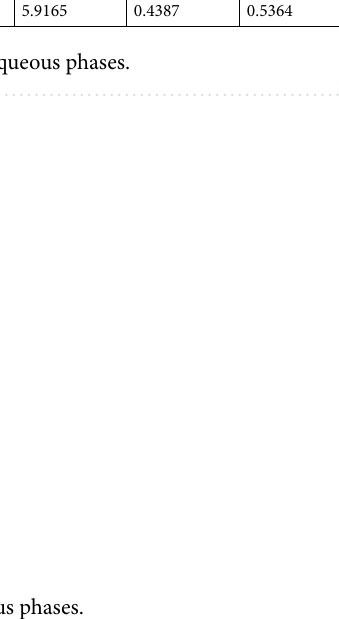
Table 2. Most active sites of f